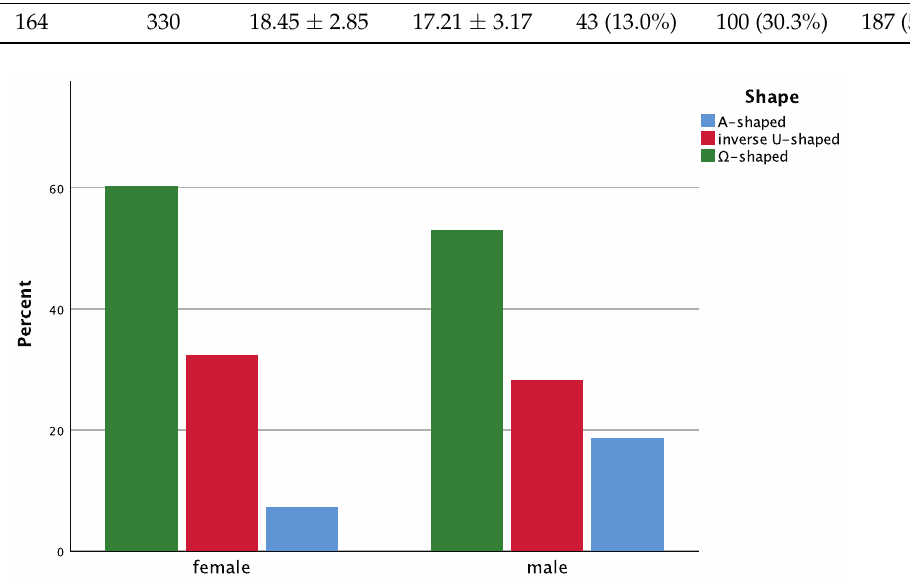
Figure 2. Distribution of the three shapes with a significant sex difference between male and female patients ( p = 0.01).